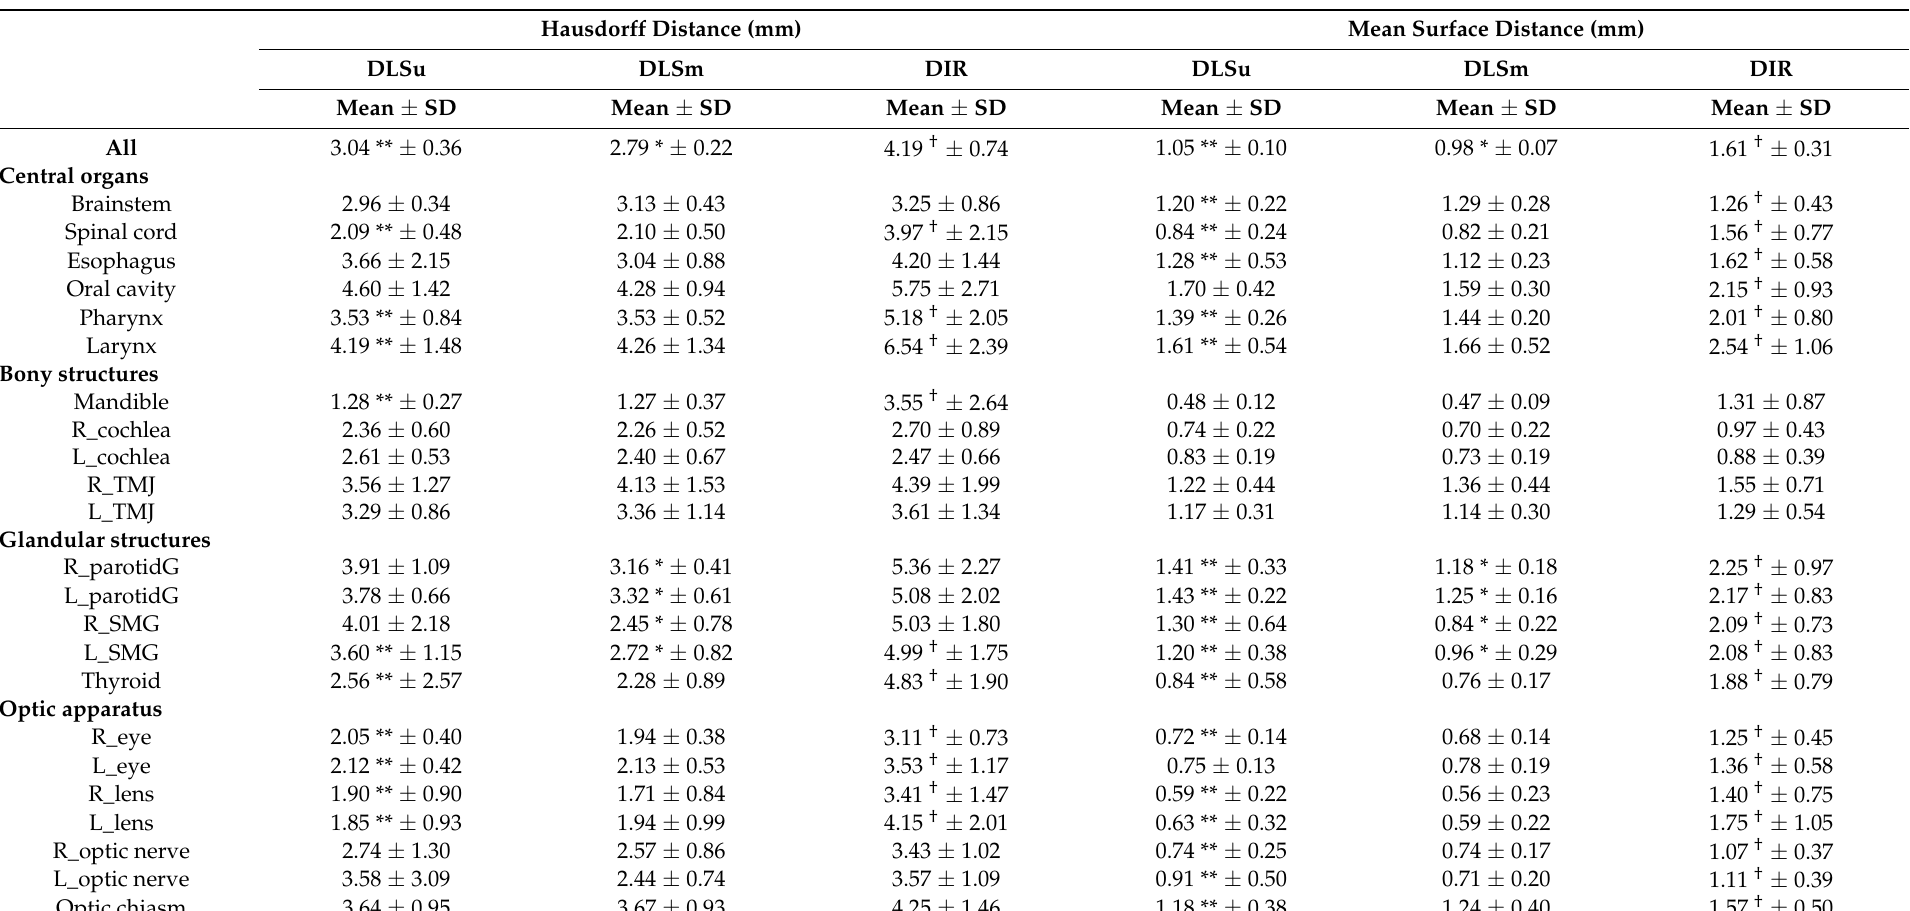
Table 2. Average Hausdorff distance and mean surface distance for deep learning-based segmentation for unmatched set (DLSu), matched training set (DLSm), and contouring from deformable image registration of primary planning computed tomography